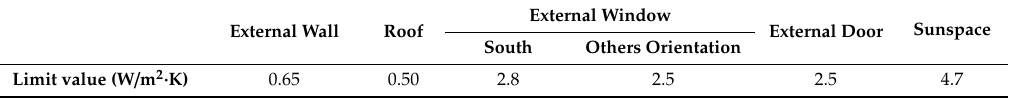
Table 3. Limit value of the heat-transfer coe ffi cient for the rural building envelope in colder regions [29]. External Window External Wall Roof External Door Sunspace South Others